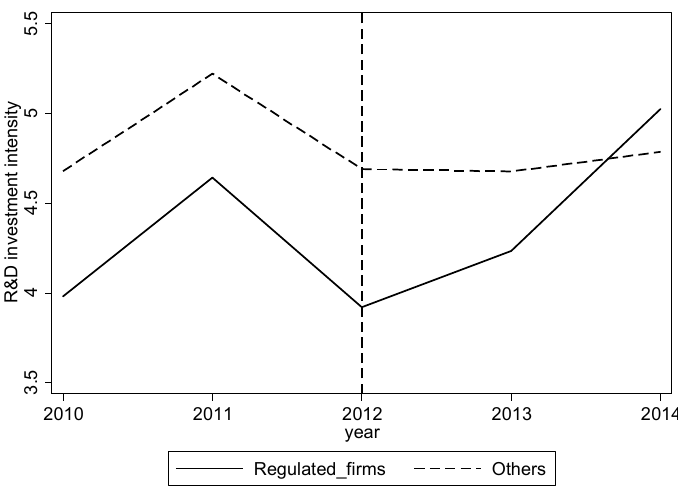
Figure 2. Change of the R&D investment intensity of two types of publicly listed private firms. Source: The original data are obtained from the CSMAR database and the websites of the Development and Reform Commissions of the seven pilots in China and calculated by Stata 14.